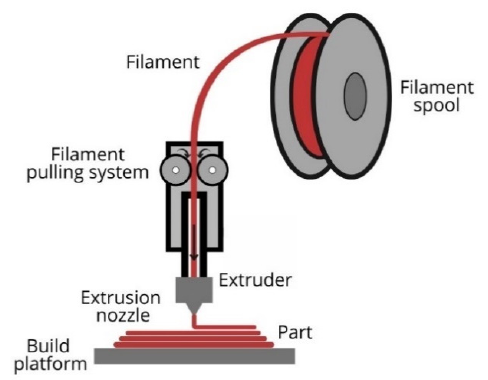
Figure 7. FDM Figure 7. FDM mechanism.